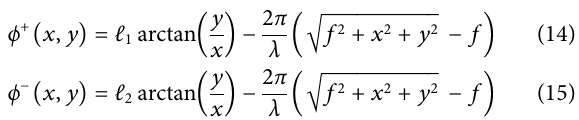
Frontiers in Physics |